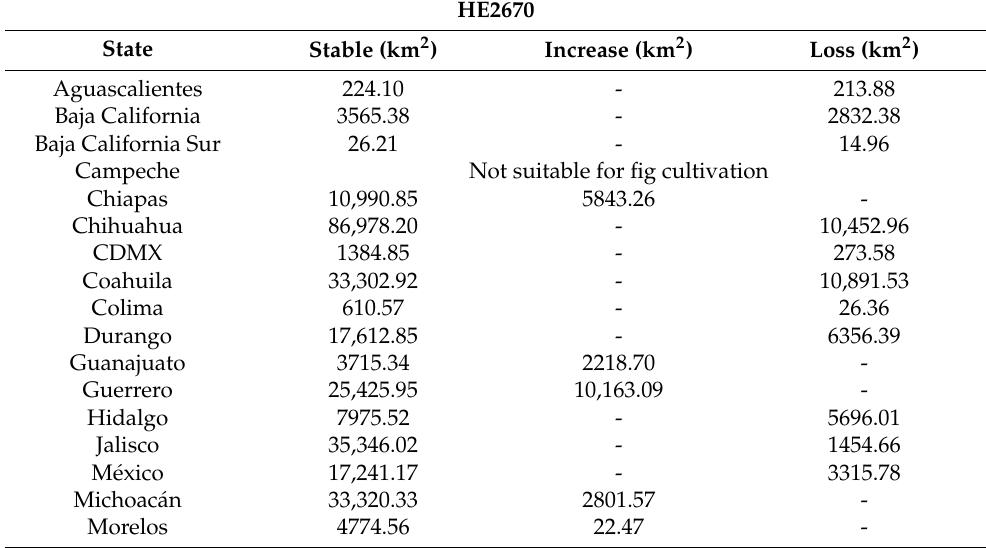
Table A5. Area estimated of fig crop for the year 2070 for the HADGEM2-ES Model with RCP